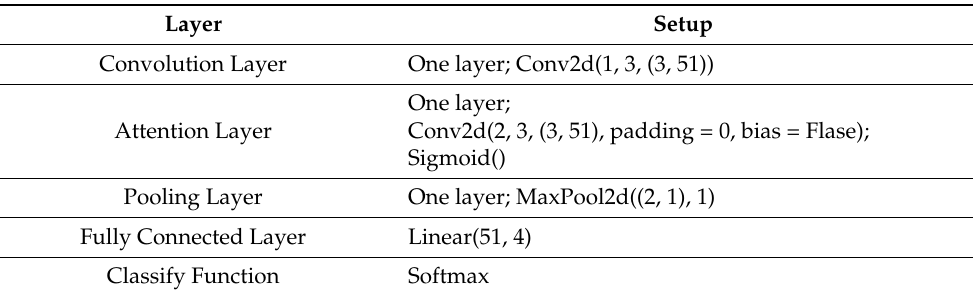
Table 3. Setup of the CNN with the attention